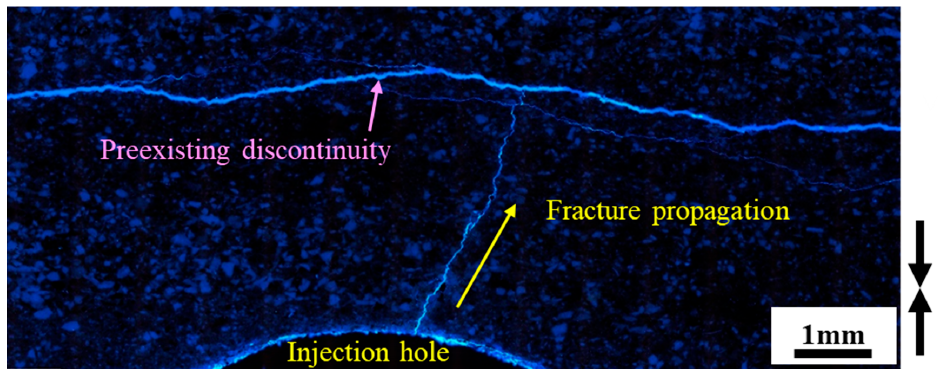
Figure 8. Stimulation of a preexisting discontinuity by a hydraulically induced fracture (Cretaceous Kushiro shale). The pair of black arrows next to the figure represents the loading direction. The induced fracture approached almost normal to the preexisting discontinuities, parallel to the sedimentary plane, and did not pass through the preexisting discontinuities. The discontinuities were impregnated by the fracturing fluid.